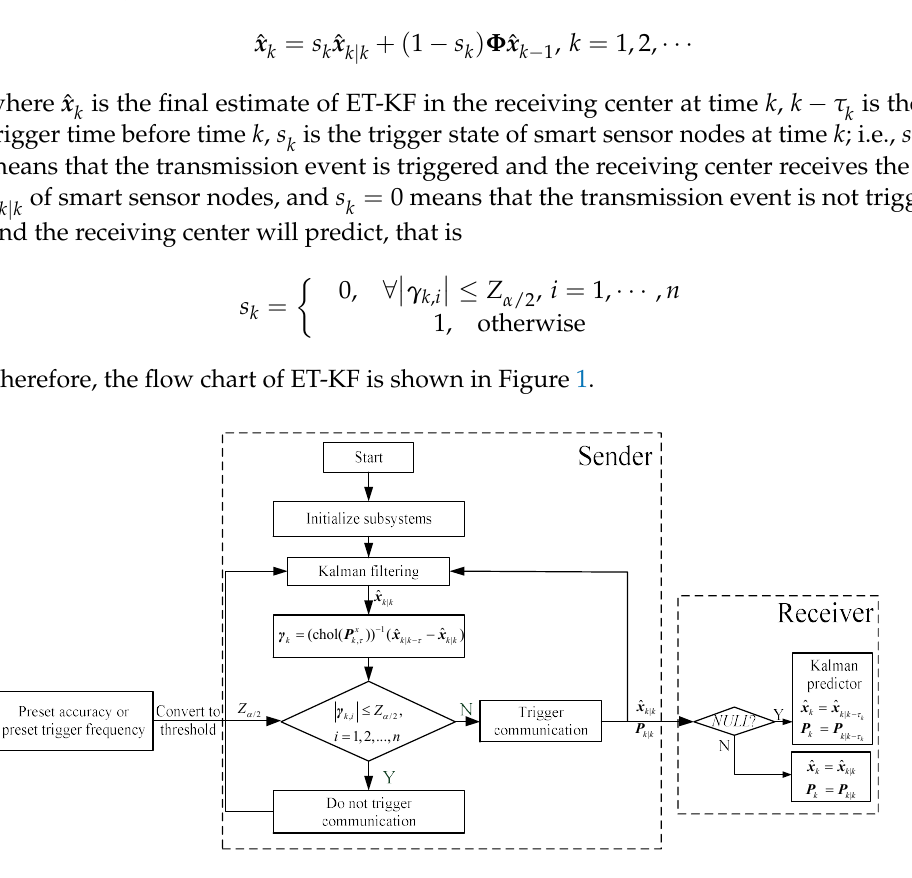
Figure 1. The flow chart of ET-KF.